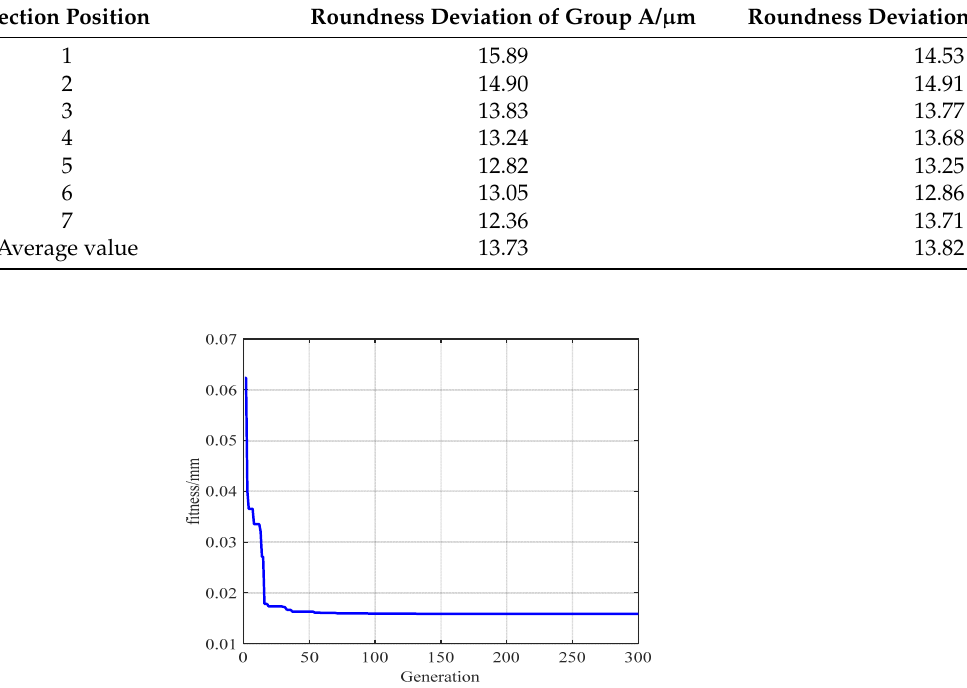
Table 3. Roundness deviation results.